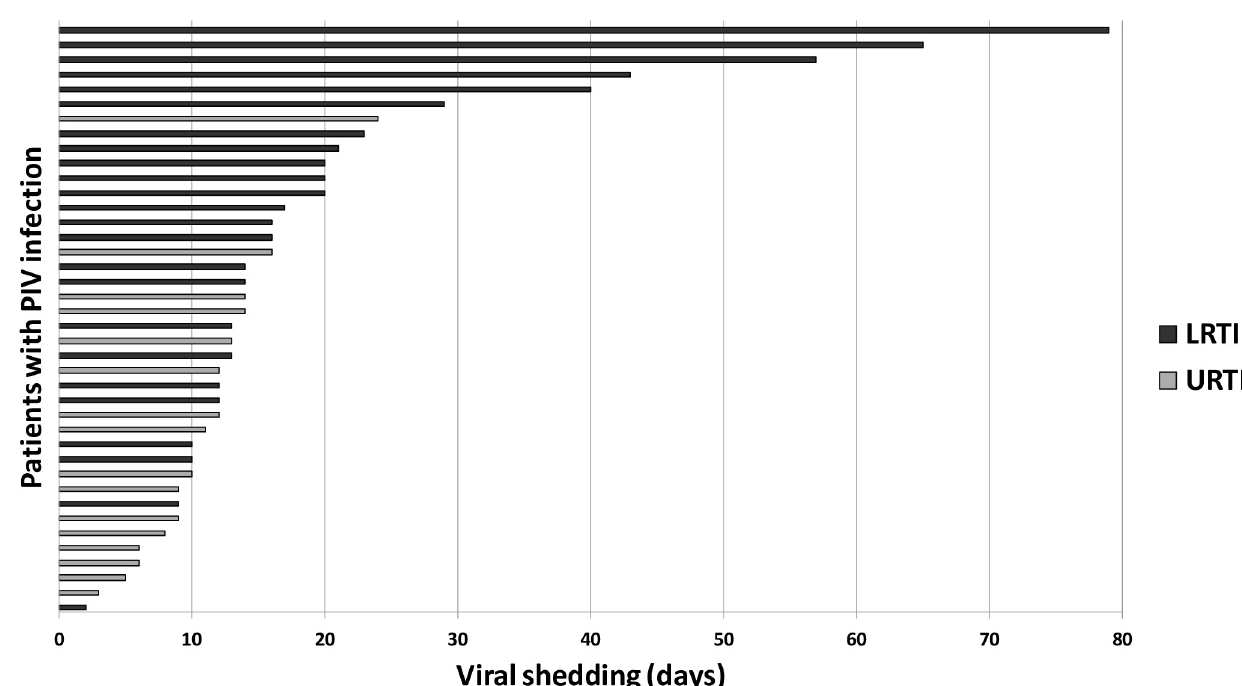
Fig 2. Duration of viral shedding in patients with PIV infection. Data on viral shedding was available in 40 patients with consecutive tests for PIV. Patients with URTI and LRTI are designated by green and red bars, resp.